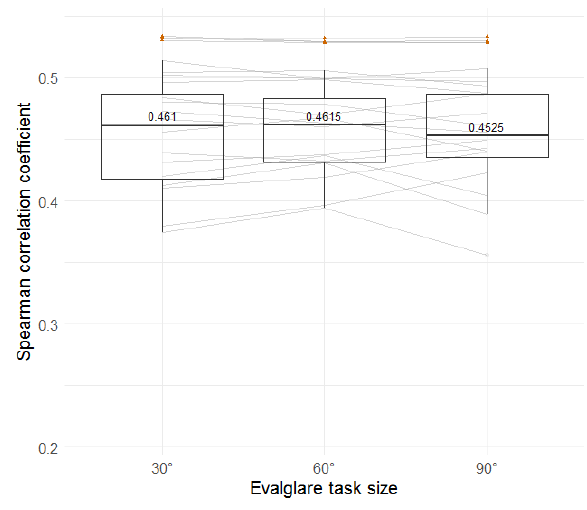
Figure 25. Boxplots of Spearman rho for the three task area sizes (laboratory study).